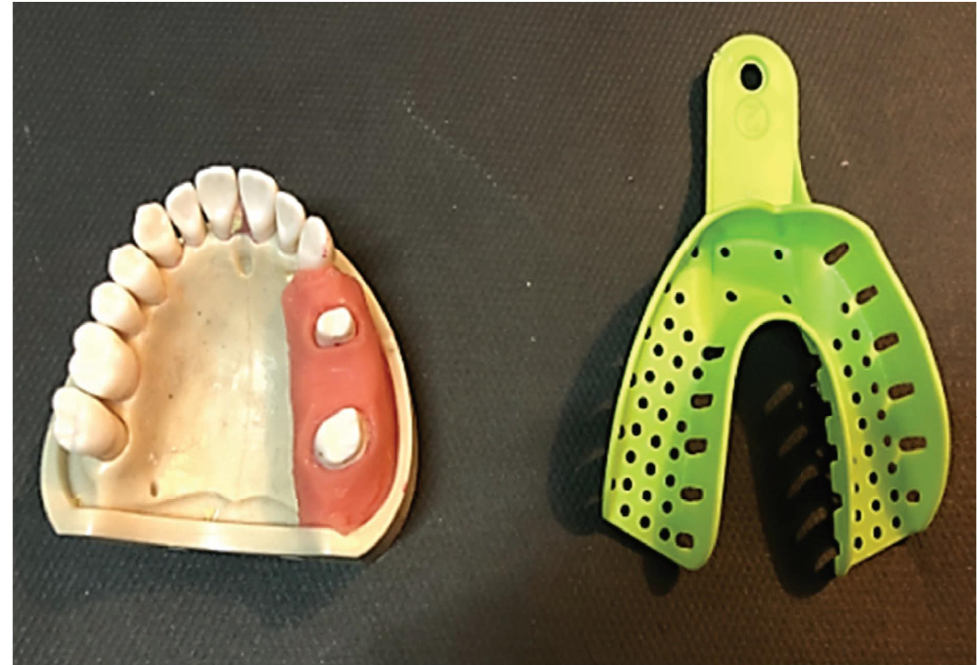
Figure 1: Te original model with the resin as soft tissue. A plastic tray was used to prepare the impression.